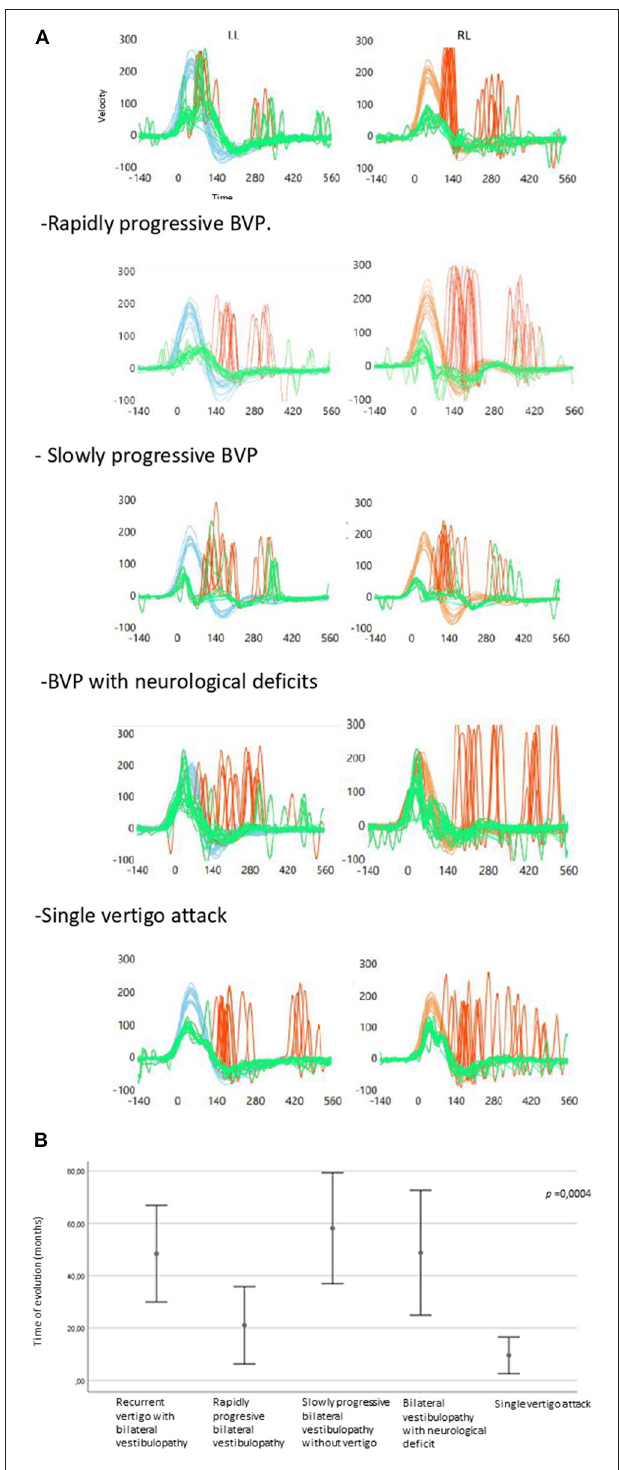
FIGURE 3 | (A) CSH-VHIT examples according to clinical subtypes in the study’s population (LL, Left lateral; RL, right lateral). Recurrent vertigo with BVP. (B) Error graph showing time of evolution regarding the clínica